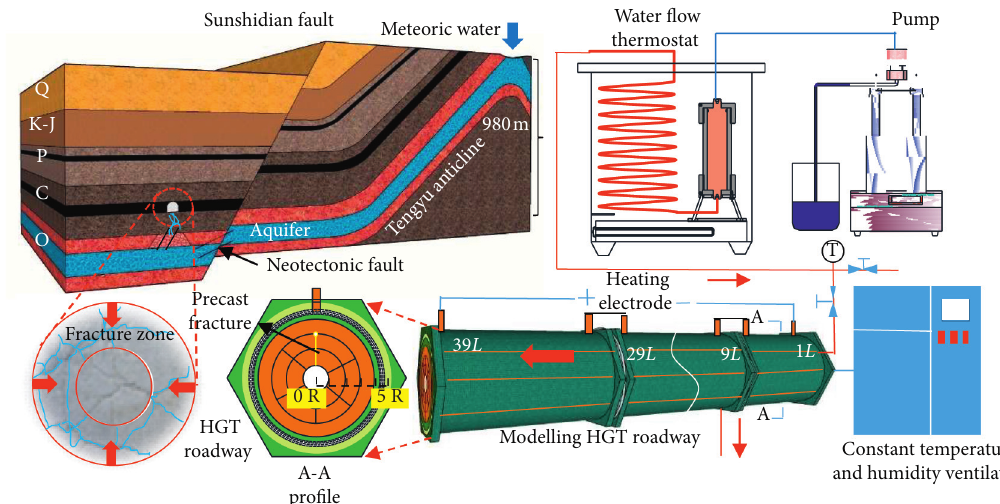
Figure 4: Experimental apparatus to modelling hot water trickling to roadway.